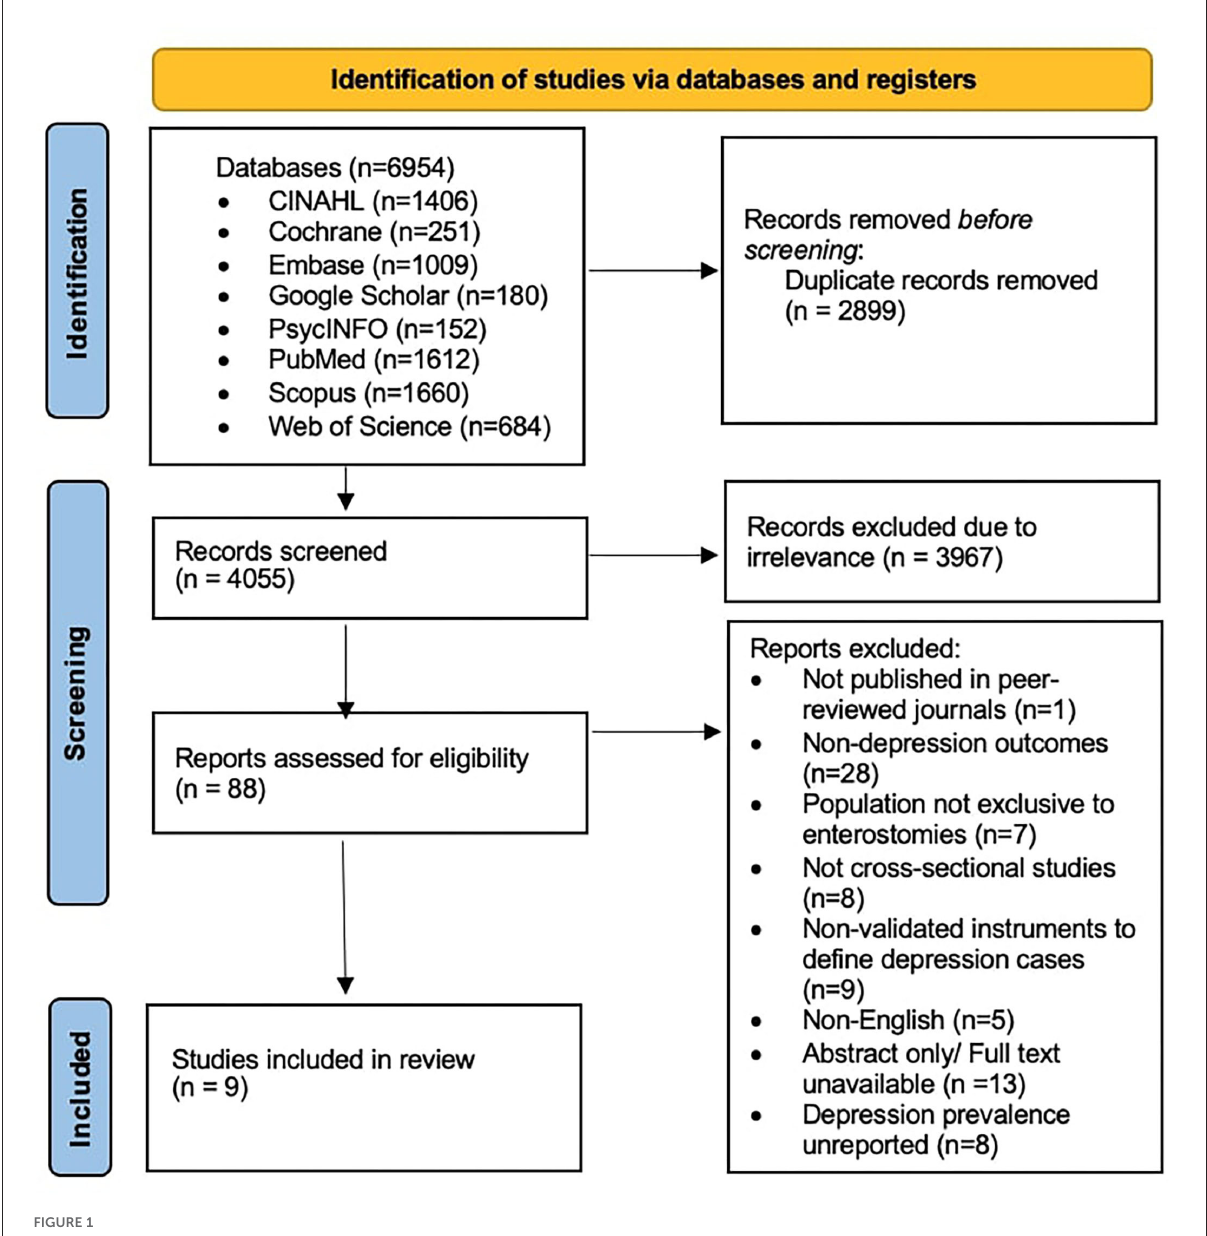
FIGURE1 PRISMA flowchart describing the study